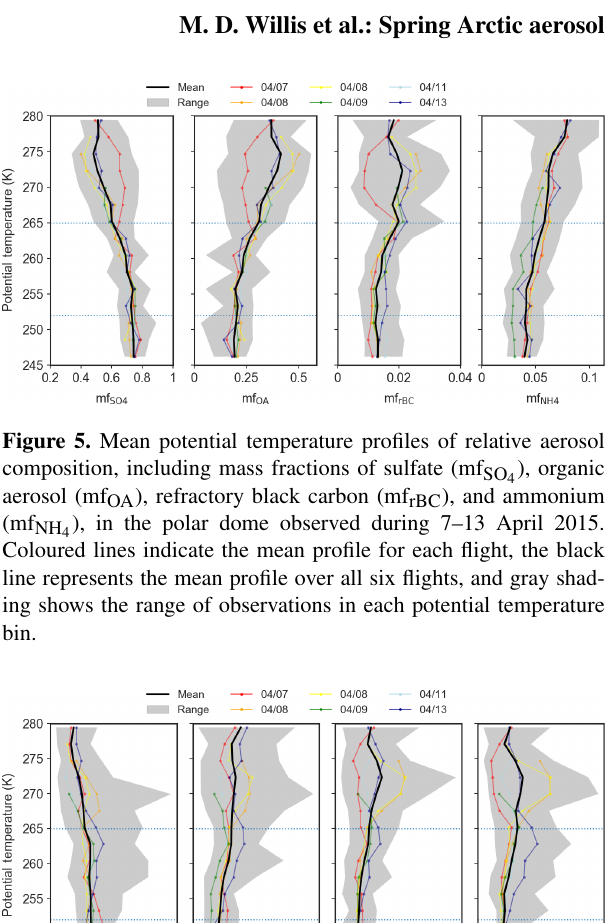
Figure 6. Mean potential temperature profiles of absolute (STP) sub-micron aerosol composition in the polar dome observed during 7–13 April 2015, including sulfate, organics and ammonium from the ToF-AMS and refractory black carbon (rBC) from the SP2. Ni- trate concentrations were negligible, and largely below detection limits. Coloured lines indicate the mean profile for each flight, the black line represents the mean profile over all six flights, and gray shading shows the range of observations in each potential tempera- ture bin. Single points at the lowest potential temperature represent concentrations of sulfate, ammonium and rBC measured at Alert, NU, during 6–13 April 2015 from Macdonald et al. (2017). Points represent the mean concentration and error bars represent measure- ment